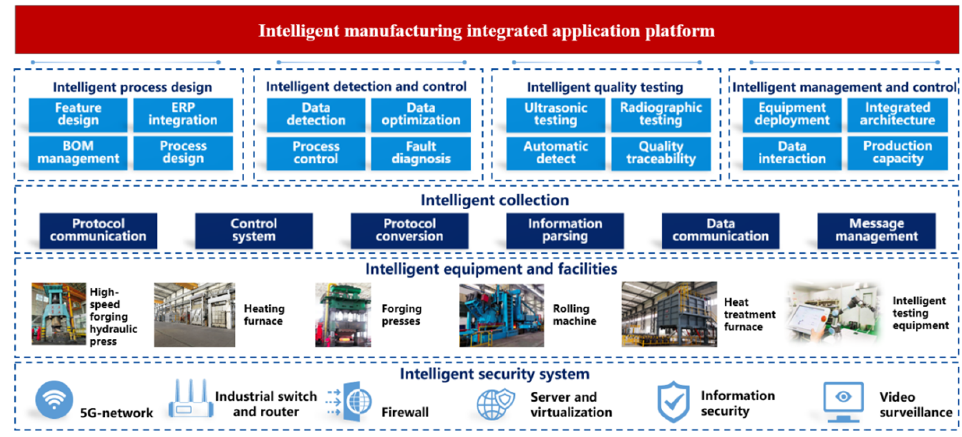
Figure 14. Architecture design of intelligent manufacturing integrated application platform based on enterprise network environment.